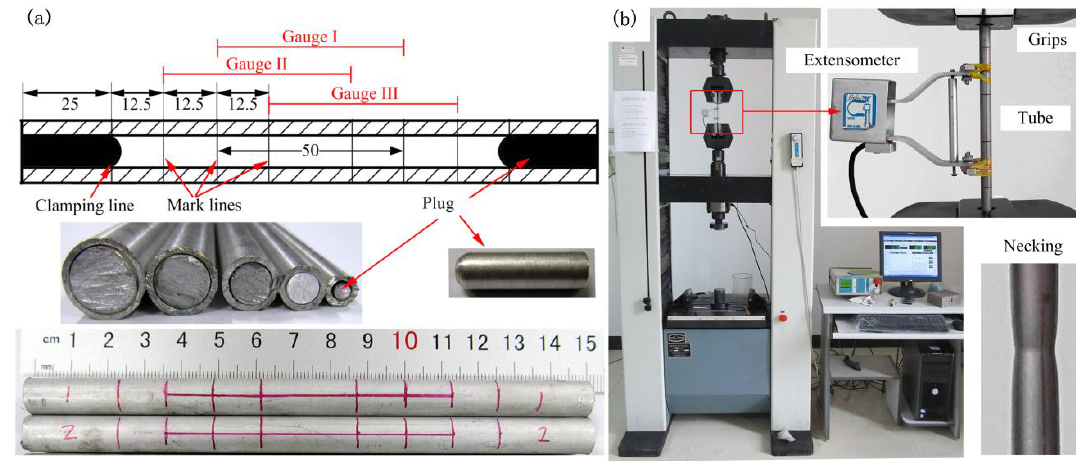
Figure 1. Specimens and test device: ( a ) dimension of the tube sample; ( b ) universal testing machine.